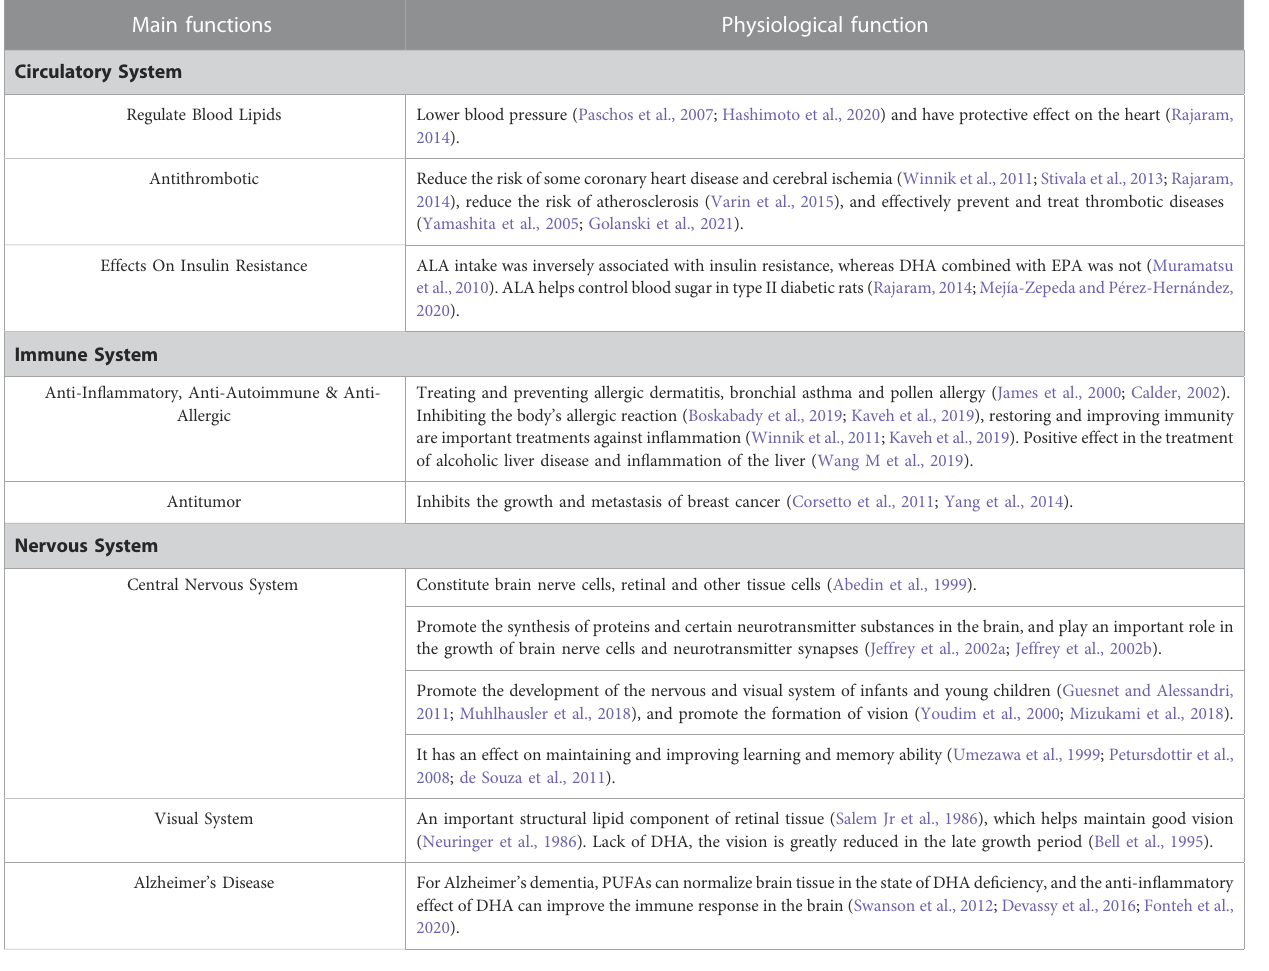
TABLE 1 The main function of